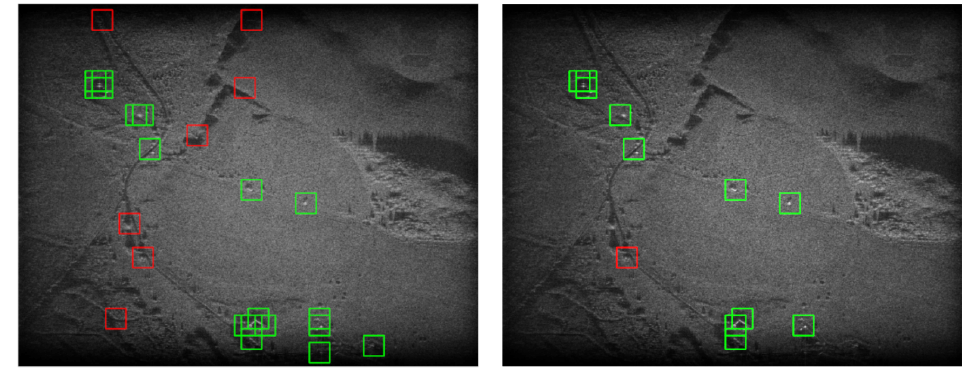
Figure 11. Comparison of the effect of partial retraining BCNN on confident incorrect detections for scene 2. From ( a , b ) it can be observed that there was a reduction in the number of false positives (red bounding boxes) over the forest region while maintaining similar detection performance (green bounding boxes) over the remaining regions. Interestingly, there was also a reduction in the number of high uncertainty regions over the forest area between ( c , d